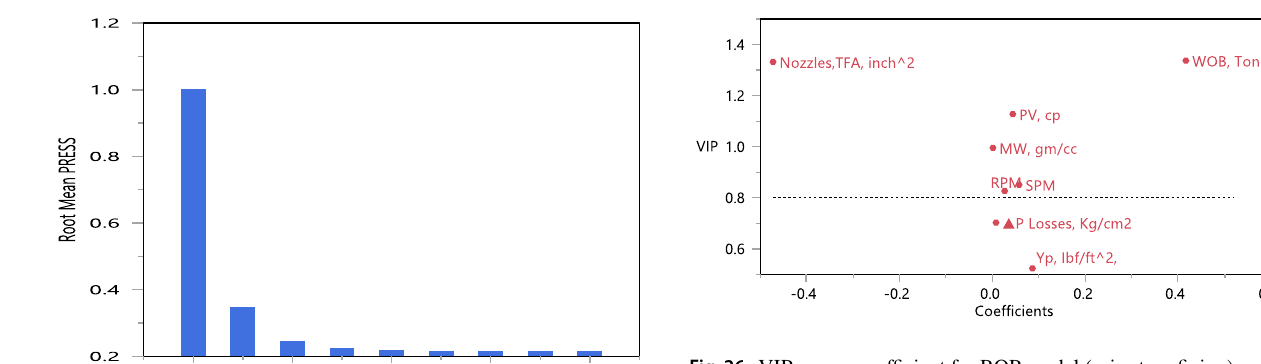
Fig. 26 VIP versus coefficient for ROP model (prior to refining)